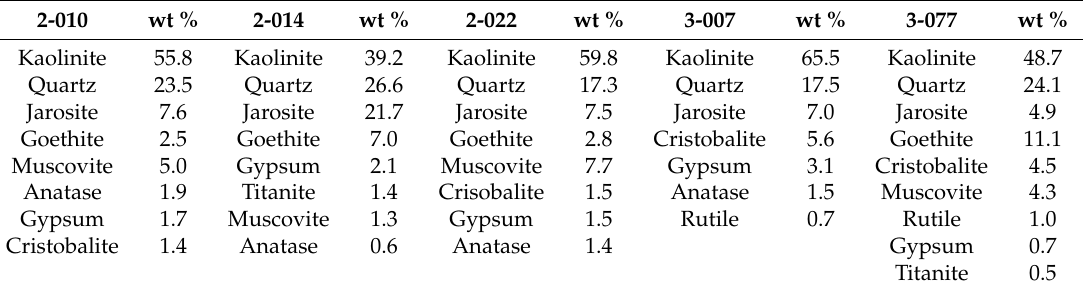
Table 4. Mineral mass fractions resulting from XRD quantitative analysis of five selected samples to represent the Litov area. AMD minerals are jarosite and geothite. The estimated standard deviation is below 0.2% for each, and the pH ranges from 2.4 to 2.7 for the shown